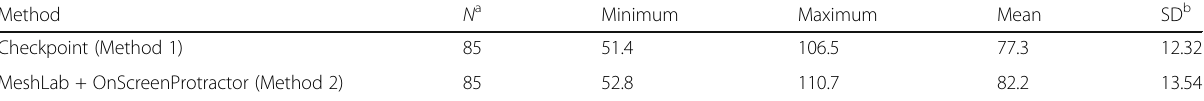
Table 2 Descriptive statistics of subpubic angle measured by Method 1 and Method 2 (in degree) Method